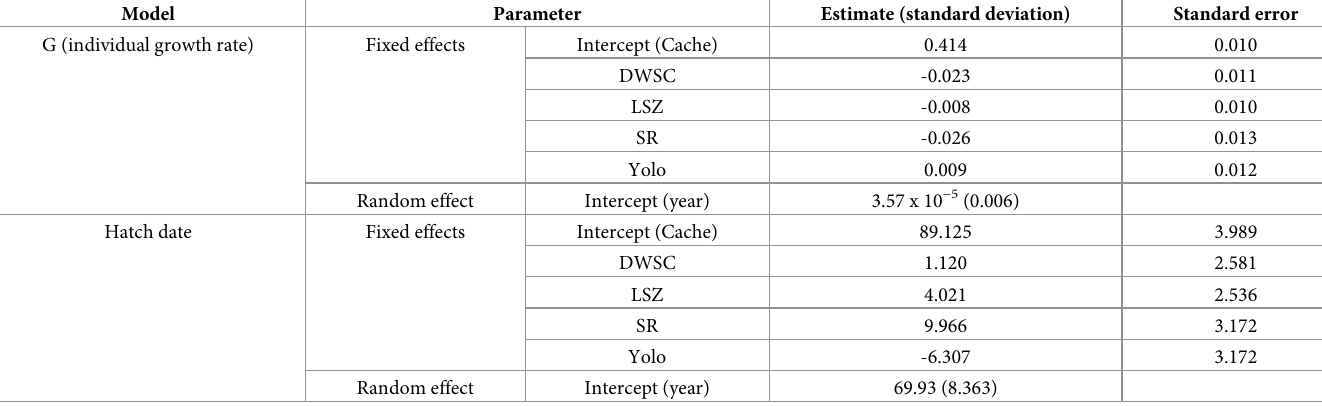
Table 2. Parameter estimates for the GLMMs used to evaluate if G and hatch date for Delta Smelt vary by region of capture. Cache = Cache Slough region, DWSC = Sacramento Deep Water Ship Channel, LSZ = low salinity zone, SR = Sacramento River, Yolo = Yolo